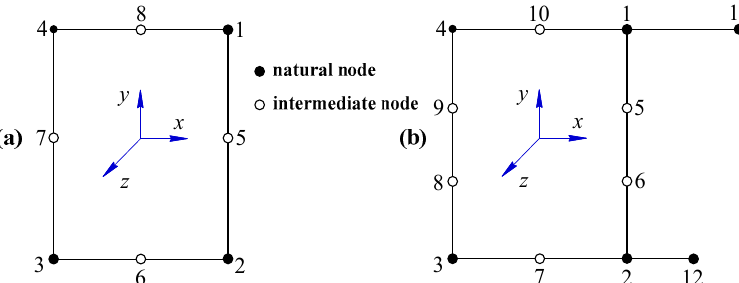
Figure 2. Discretization of a prismatic thin-walled cross-section: ( a ) A rectangular hollow cross-section; ( b ) a branched hollow cross-section.